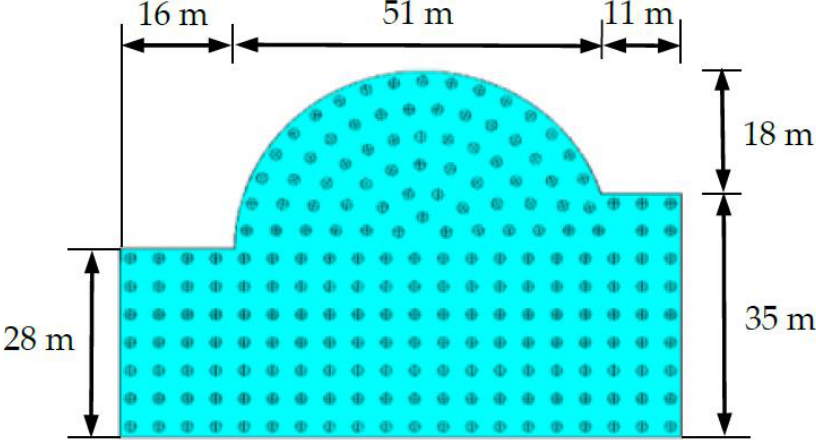
Figure 6. Detailed dimensions of the irregular raft in Case 3.